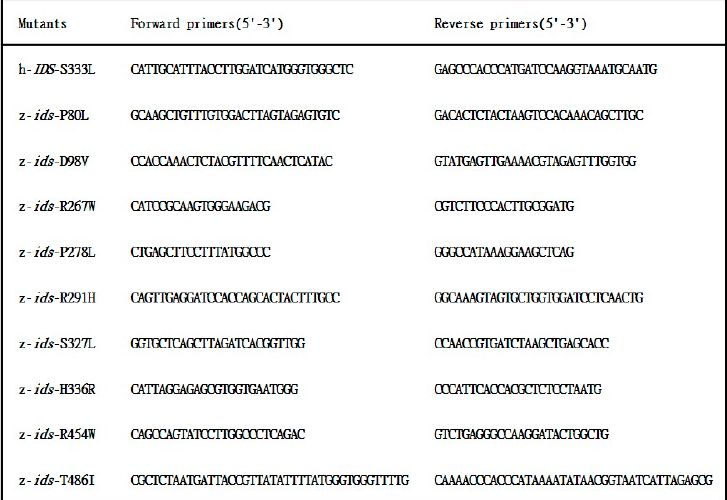
Figure A1. Primers used for site-directed mutagenesis. Diagnostics 2020 , 10 , x FOR PEER REVIEW